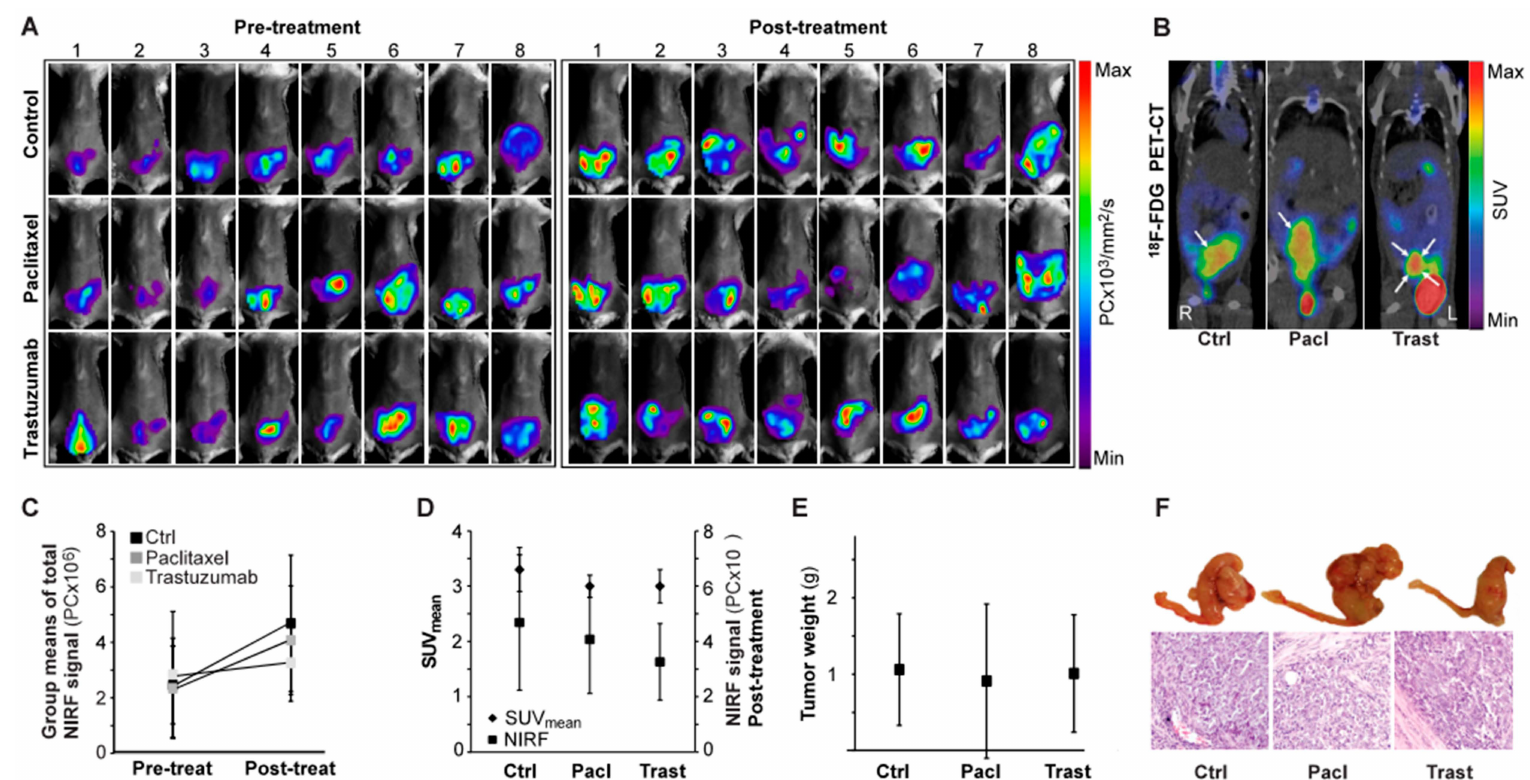
Figure 6. In vivo monitoring of paclitaxel or trastuzumab treatment in an endometrial carcinoma PDX model using EpCAM-AF680 NIRF imaging. EpCAM-AF680 NIRF images of mice treated with control vehicle ( n = 8), paclitaxel ( n = 8) or trastuzumab ( n = 8) prior to (day 26) and after (day 55) treatment. Pre-and post-treatment scans were paired and signal intensity scale synchronized for each individual mouse ( A ). Representative 18 F-FDG PET / CT images (day 47), uterine tumors are indicated by arrows ( B ). Group means of total fluorescent signal before (day 26) and after (day 55) treatment, n = 8 mice per group ( C ). Group means of total fluorescent signal after treatment (day 55, n = 8 mice per group) compared to group SUV mean values measured in 18 F-FDG PET / CT scans at day 47, control group: n = 6, paclitaxel group: n = 5, trastuzumab: n = 6 ( D ). Tumor weights after necropsy on day 49 (control group: mouse 1, paclitaxel group: mouse 2), day 51(control group: mice 3 and 8, trastuzumab group: mouse 2) or day 57 (all other mice), n = 8 in all groups (20 × magnification) ( E , F ). Graphs are group means +/ − SD. Abbreviations: Epithelial cell adherence molecule (EpCAM), Fluorine-18-fluorodeoxyglucose ( 18 F-FDG), Metabolic tumor volume (MTV), Near infrared fluorescence (NIRF), Positron emission tomography / computed tomography (PET / CT), and Standardized uptake value